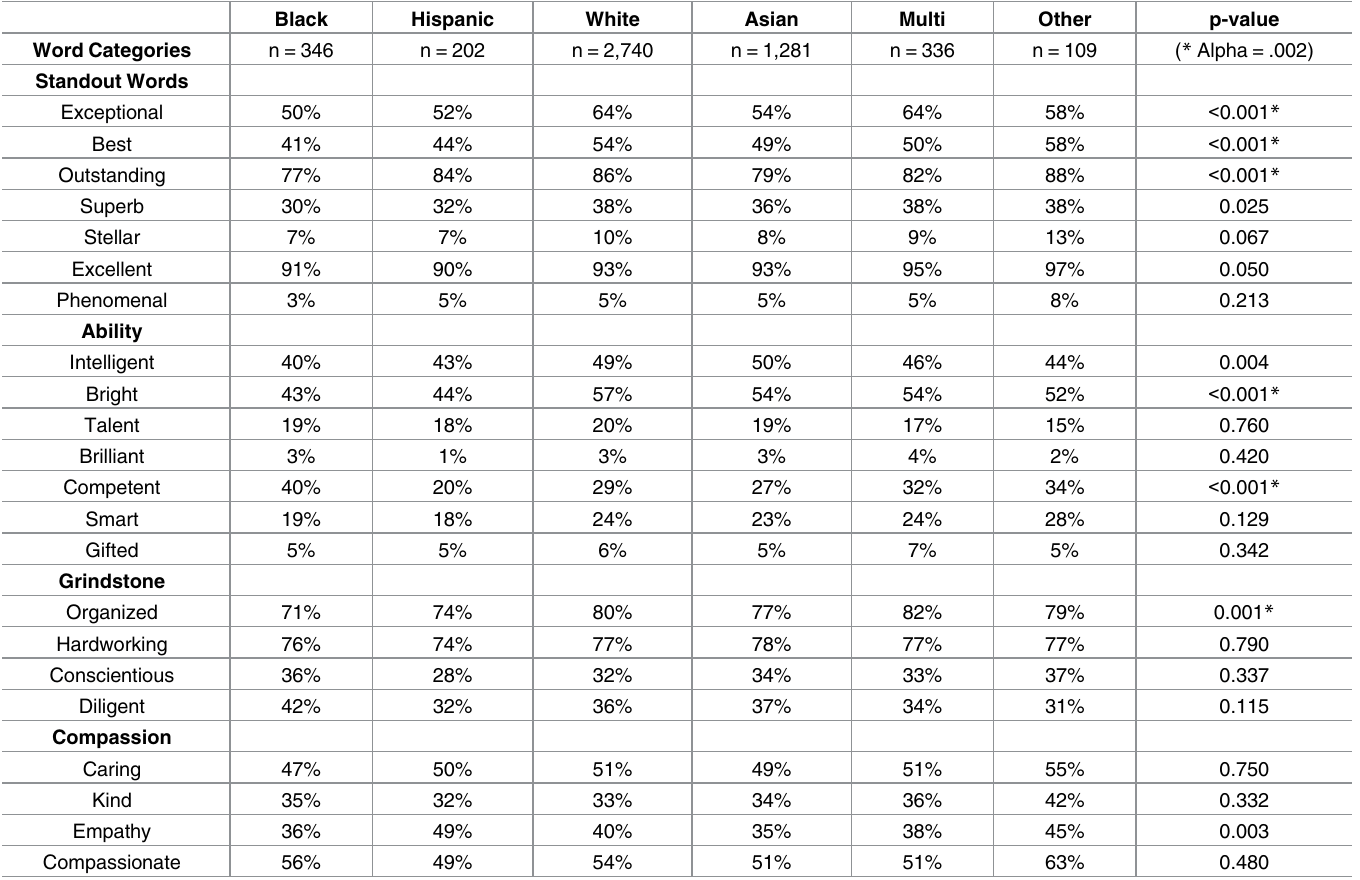
Table 4. Percentage of applicants by race/ethnicity group for whom each descriptive word was used at least once in the Medical Student Perfor- mance Evaluation. Black Hispanic White Asian Multi Other